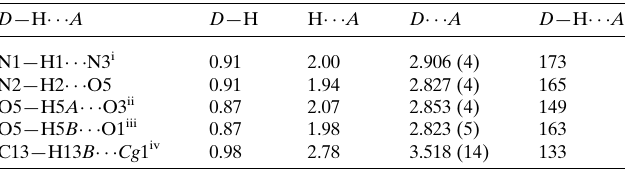
Table 1 Hydrogen-bond geometry (A˚ , (cid:3) ).